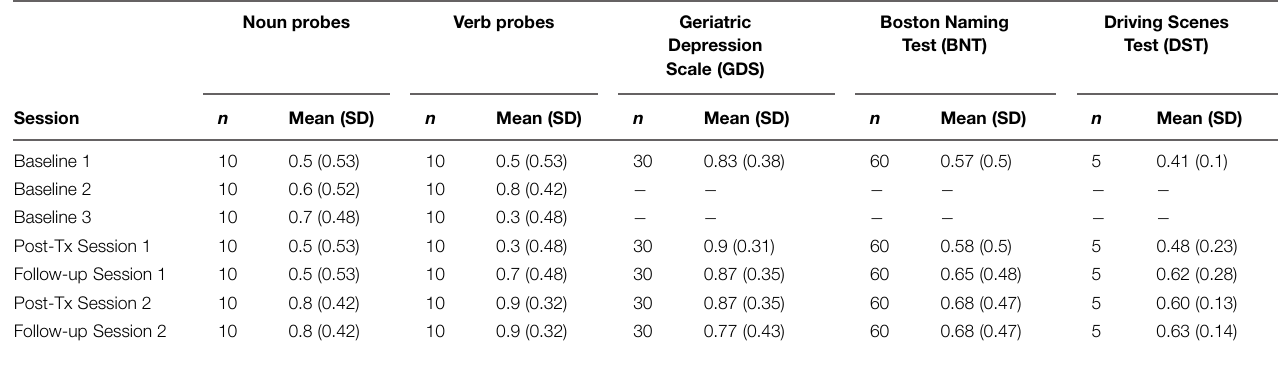
TABLE 2 | Mean task accuracy by